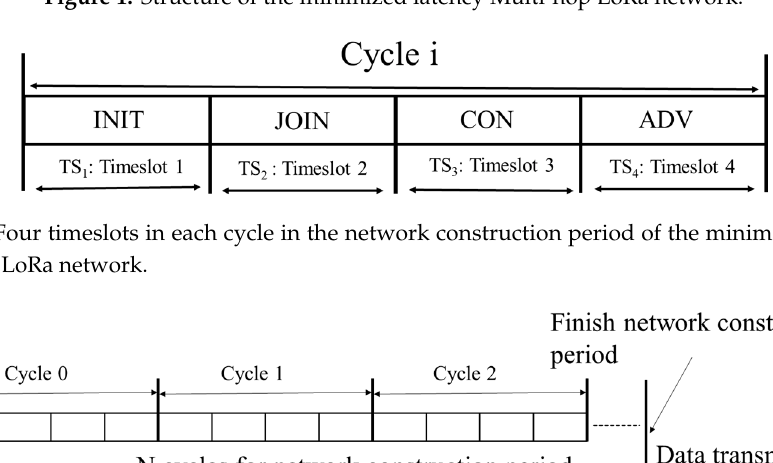
Figure 1. Structure of the minimized latency Multi-hop LoRa network.